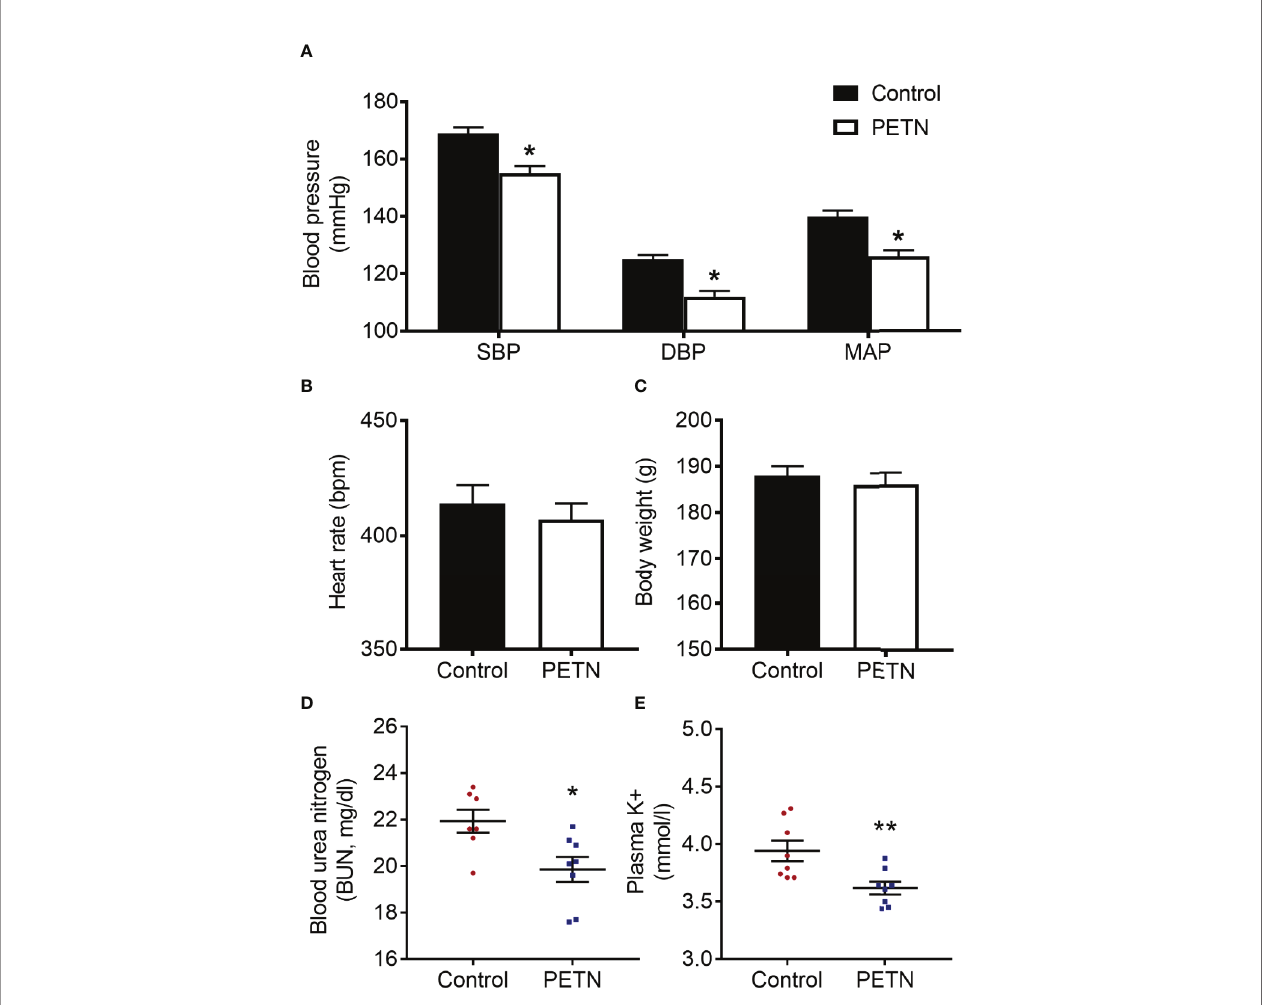
FIGURE 1 | Maternal pentaerythritol tetranitrate (PETN) treatment leads to blood pressure and kidney injury reduction in early ages of female offspring (16 weeks). Parental spontaneously hypertensive rats (SHR) were treated with or without PETN (50 mg/kg/day) during pregnancy and lactation periods. Systolic blood pressure (SBP) , diastolic blood pressure (DBP), and mean arterial pressure (MAP) (A) ; heart rate (B) and body weight (C) were measured in the offspring at 16 weeks. Column represents mean ± SEM, n=25 − 26. Plasma samples were obtained from the female offspring (16 weeks) from each group for the measurement of the blood urea nitrogen (BUN) (D) and potassium ion concentration (E) using a blood chemical analyser (Re fl otron, Roche Co., Germany). Student ’ s t test was used for comparison of PETN group with control group. * P < 0.05; ** P < 0.01; vs. control